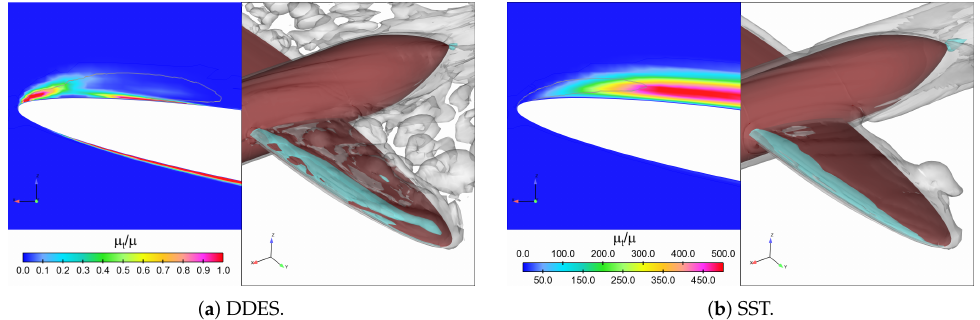
Figure 20. Snapshots of simulations with DDES and SST. Medium grid, σ = 1.27. Left frame depicts a cut plane of the left foil at mid-span with the contour of void fraction α = 0.1 denoted by the grey curves, and the plane is colored by the eddy-viscosity ratio. The right frame shows the cavity extent near the left foil by an iso-surface of the void fraction α = 0.1, colored by light blue, and vortical flow structures by an iso-surface of | Ω i | = 300 1/s as the transparent grey